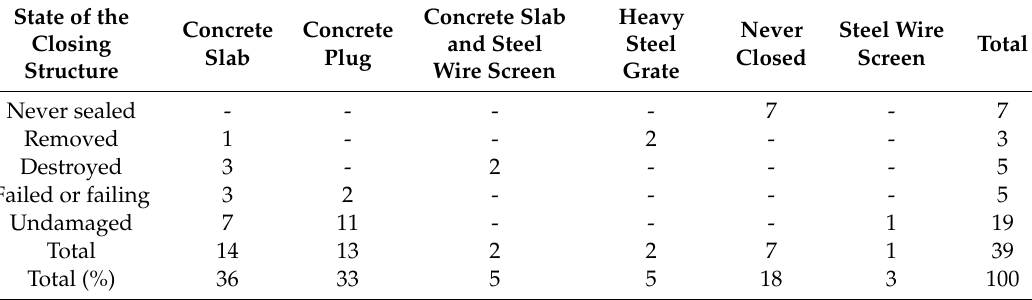
Table 2. The di ff erent strategies used to treat abandoned mine shafts in the Giyani and Musina areas